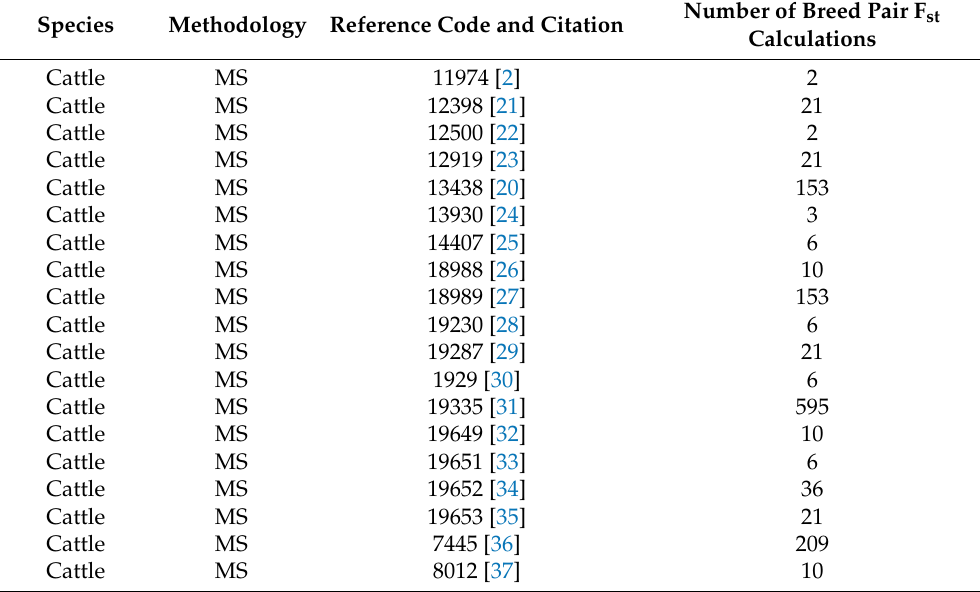
Table 1. Data sources. MS: microsatellites; SNP: single-nucleotide polymorphisms. The reference codes are internal to the project and enable cross-reference to Supplementary Information